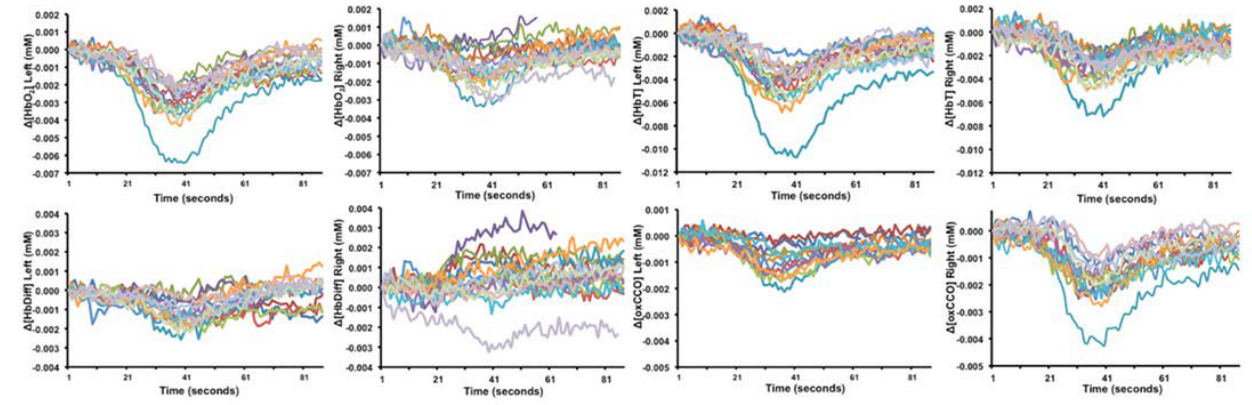
Figure 3. Transient haemodynamic and metabolic oscillatory changes in the postictal period following perinatal stroke [77]. Each colour indicates a separate event. Reproduced with permission under the Creative Commons Attribution 4.0 International License (http://creativecommons.org/licenses/by/ 4.0/) accessed 26 June